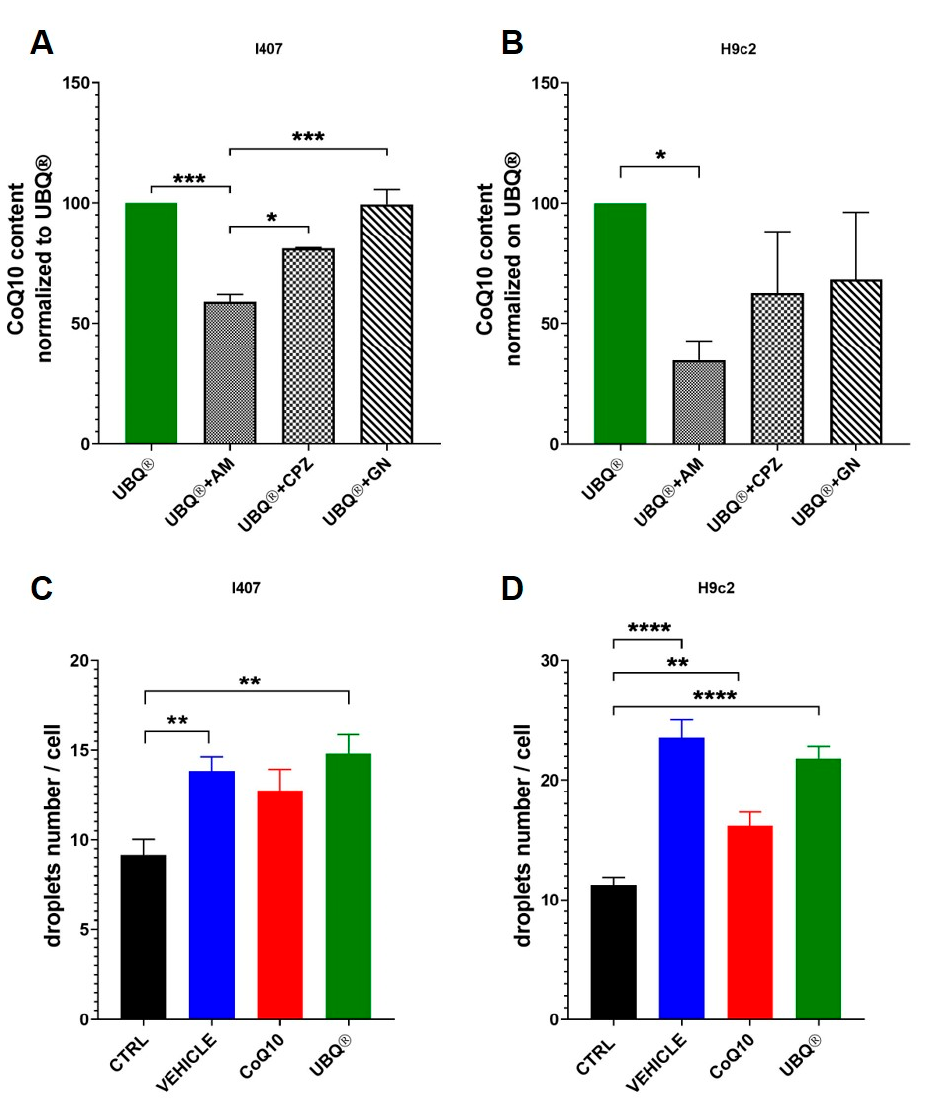
Figure 6. Cellular uptake of UBQ formulation. I407 ( A ) and H9c2 ( B ) cells were incubated for 30 min with 2 µ M of amiloride (AM), 10 µ g/mL chlorpromazine (CPZ) and 200 µ M genistein (GN) and then further incubated for three hours with 100 nM of CoQ10 phytosome formulation (UBQ). The Coenzyme Q10 content was quantified by HPLC. Data are presented as a percentage of cellular Coenzyme Q10 content compared to control samples treated with UBQ. ( n = 3). The presence of lipid droplets after products incubation was detected in fixed I407 ( C ) and H9c2 ( D ) cells by confocal microscopy using the fluorescent dye Nile Red. For each condition, at least three fields were randomly selected and the quantification of the number of positive Nile red spots per single cell was performed using the ImageJ software. For all panels, data are the mean ± s.e.m, * p ≤ 0.05; ** p ≤ 0.01; *** p ≤ 0.001; **** p ≤ 0.05. Statistical analysis was performed using one-way ANOVA followed by Tukey’s honest significant difference